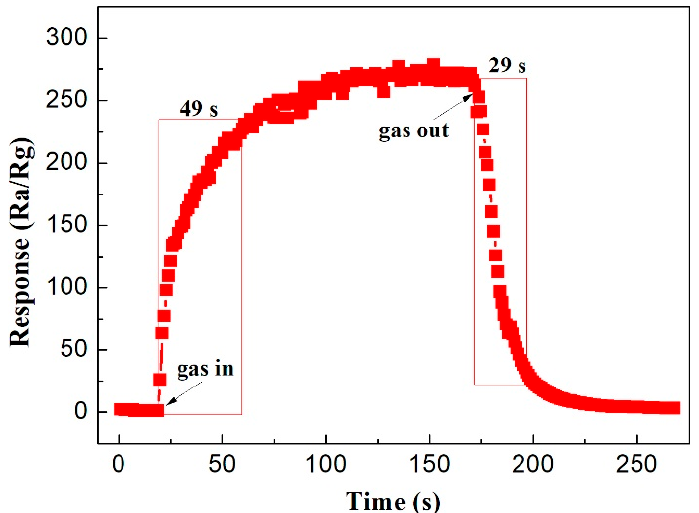
Figure 9. Response – recovery time curve of MgFe 2 O 4 /g-C 3 N 4 -10-based sensor to 500 ppm acetone at working temperature of 320 °C.